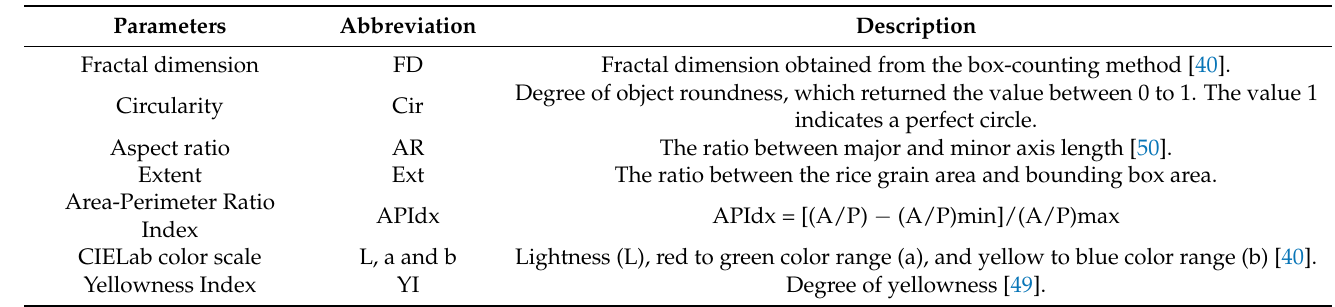
Table 2. The adimensional morpho-colorimetric features and indices that were used to develop the ML (machine learning) model to classify 15 types of commercial rice